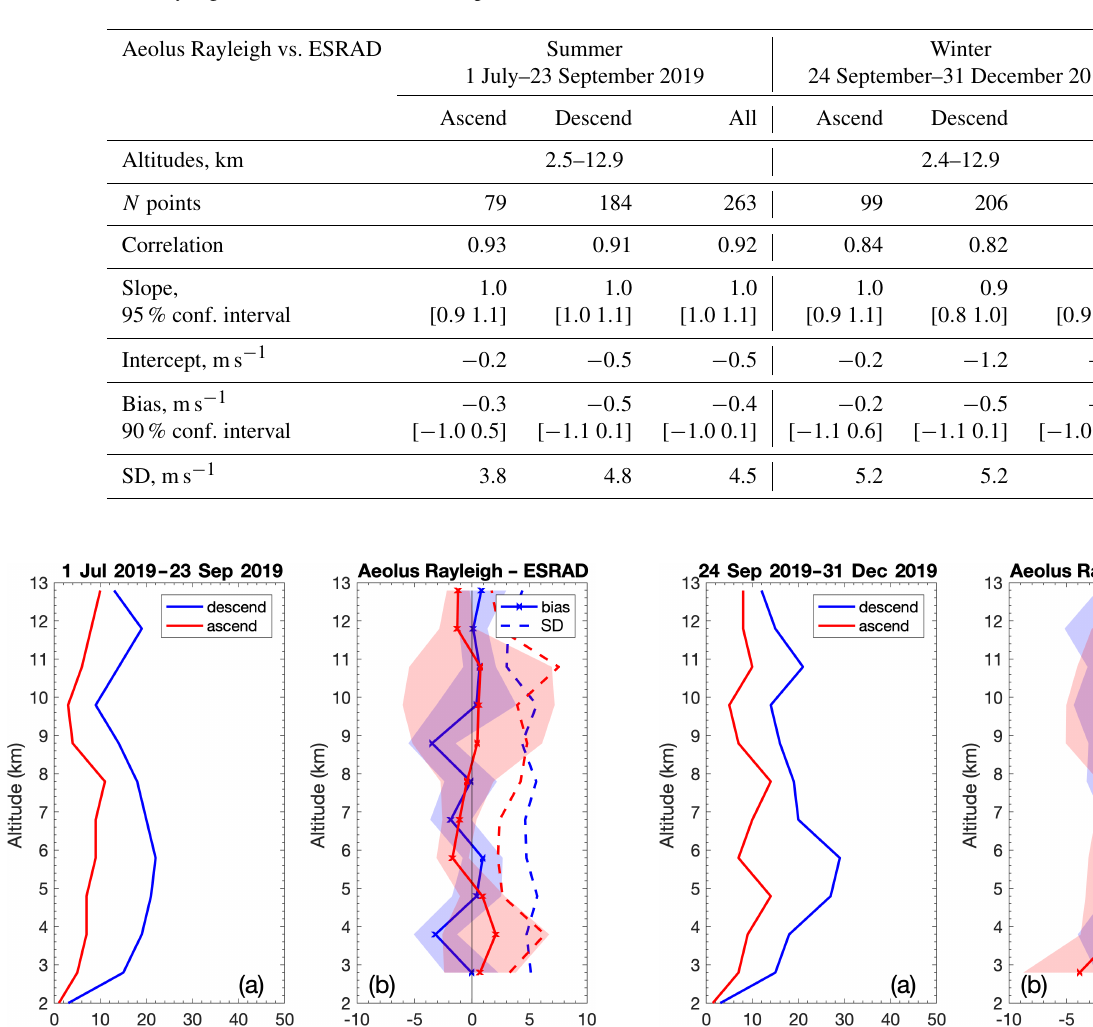
Table 4. Aeolus Rayleigh–ESRAD HLOS wind comparison.